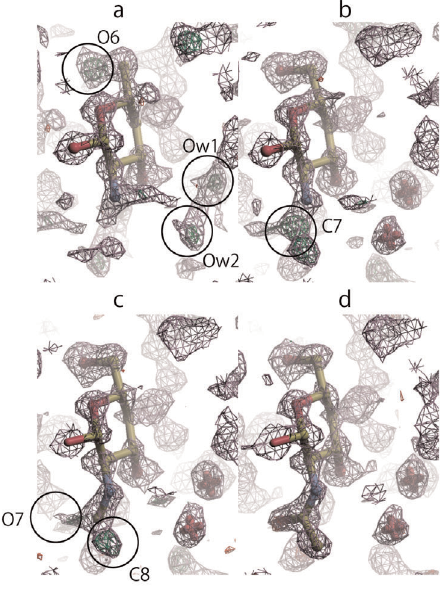
Figure 3. X-ray Fourier omit maps. Section through the X-ray s A map (showing positive density in blue) and the X-ray Fo-Fc omit map (showing positive and negative density in green and red, respectively). (a) Calculated using only the rigid backbone (omitting O6, C7, C8 and O7) as phasing model. Density indicated by circles can be associated with the hydroxymethyl oxygen O6 and two water molecules Ow1 and Ow2. (b) Calculated after introduction of O6 and the water oxygen atoms. Density indicated by circles can be associated with acetamide C7. (c) Calculated after further addition of C7. Density indicated by circles can be associated with C8, and O7. (d) Calculated with the complete molecular model (excluding hydrogen). doi:10.1371/journal.pone.0039376.g003 PLoS ONE |